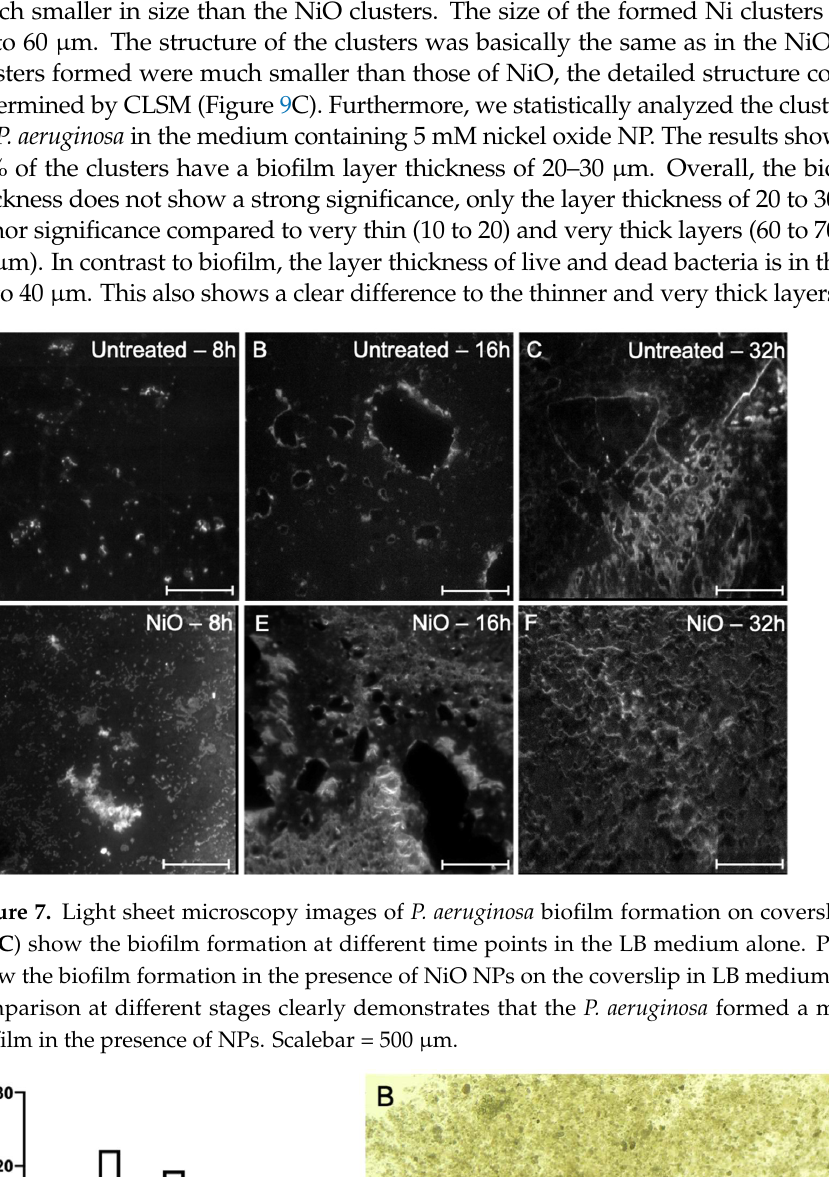
Figure 6. EDX analysis of the cluster formed in a medium containing 5 mM nickel oxide NPs and P. aeruginosa after 32 h of cultivation. The results of EDX analysis show that the cluster formed consisted mainly of nickel and oxygen ( A ). SEM enlargement of cluster ( B ).